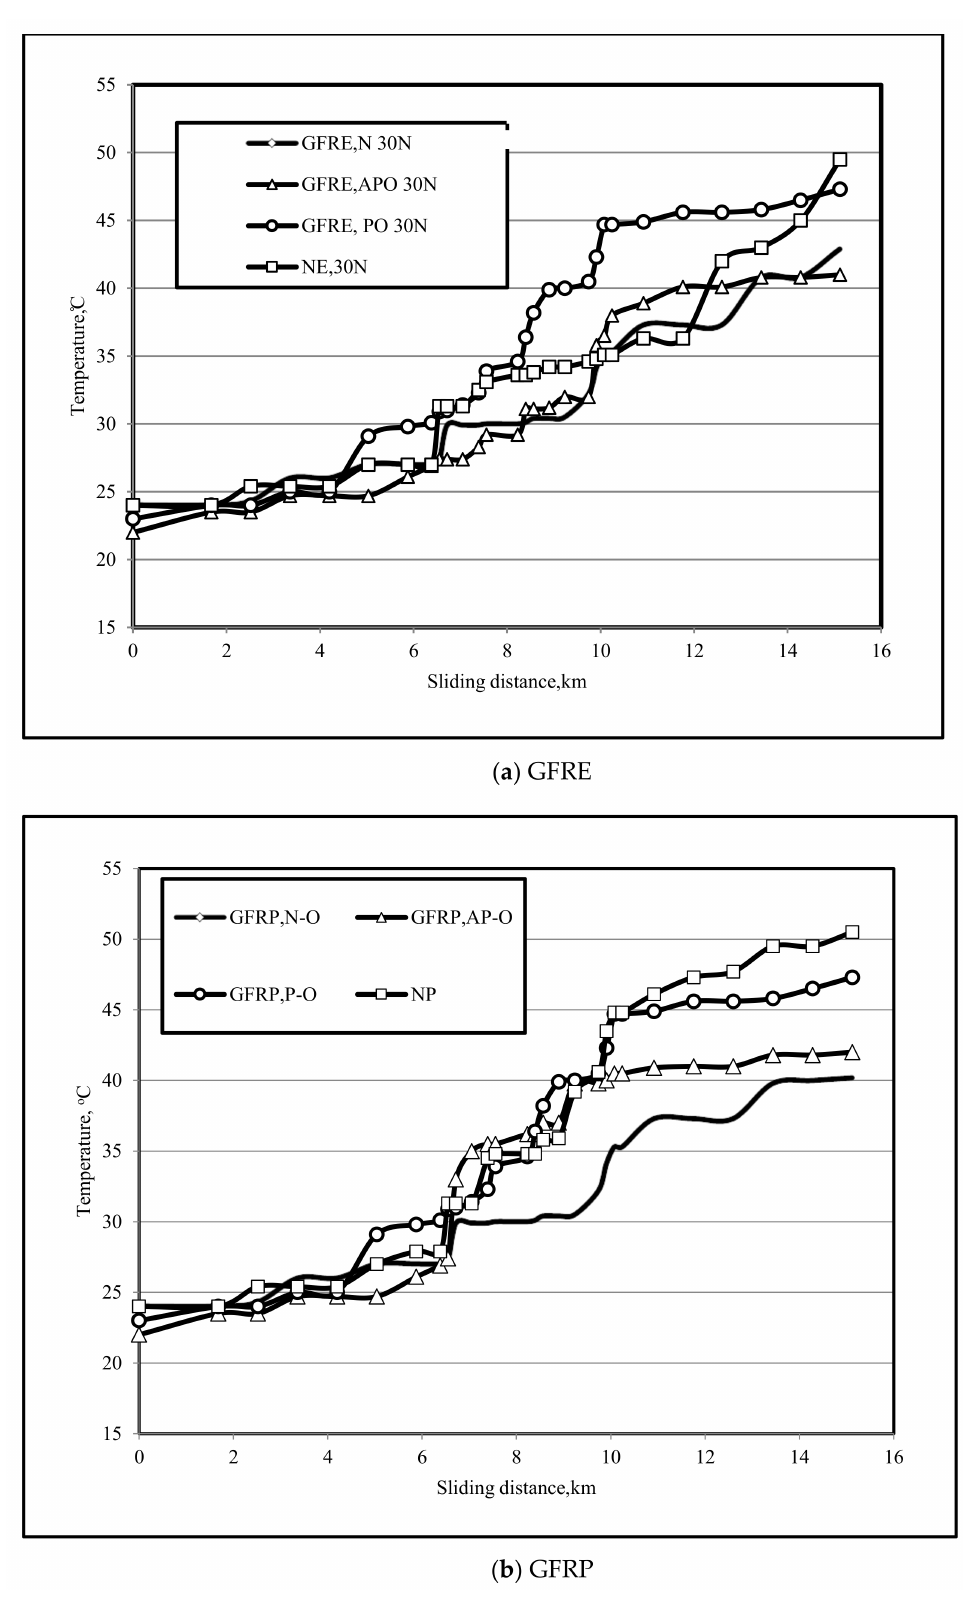
Figure 7. Interface temperatures of ( a ) GFRE and ( b ) GFRP under an applied load of 30